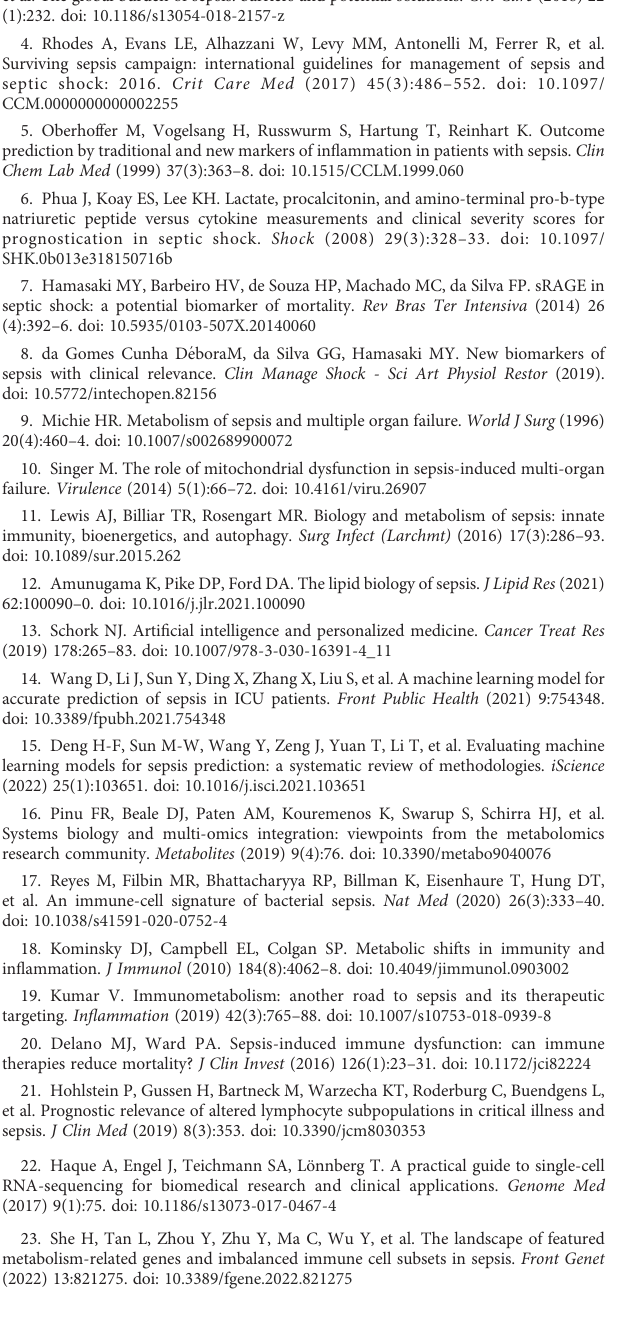
SUPPLEMENTARY FIGURE 1 (A) UMAP plots of clusters in each sample. (B) DEGs between HC and SP in T cells, B cells, and monocytes.